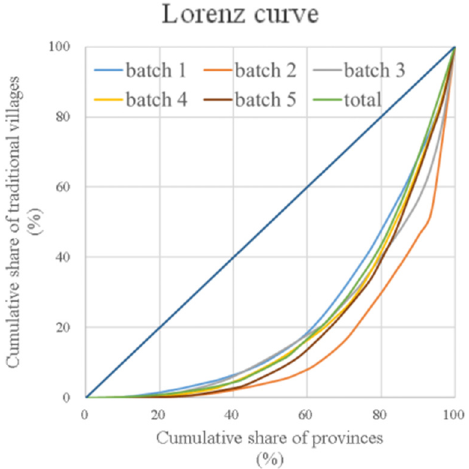
Figure 2. Lorenz curves of traditional